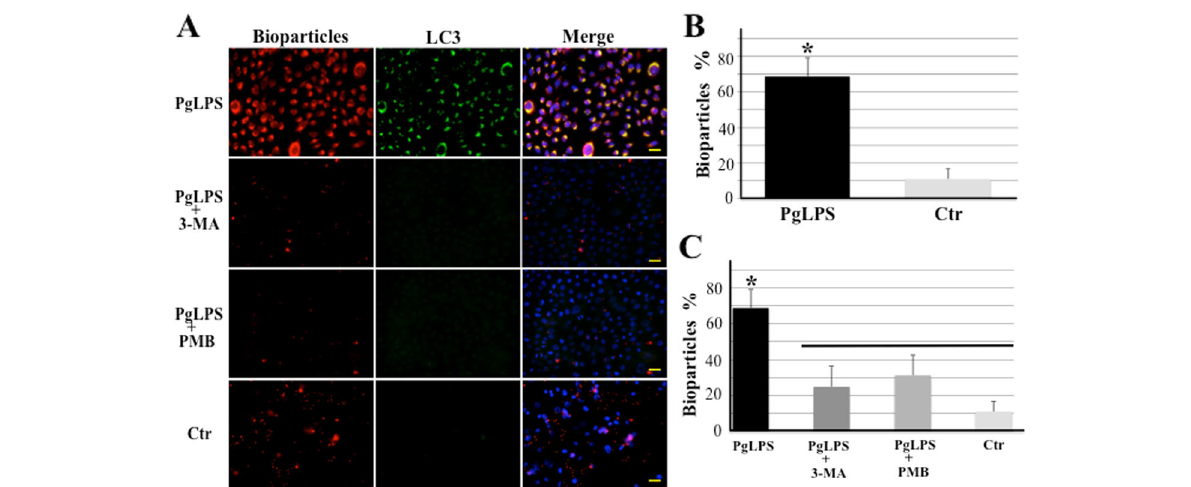
Fig. 8 Co-localization of E. coli BioParticles with autophagosomes is promoted by PgLPS-induced autophagy. HaCaT cells were infected with Alexa Fluor 568-labeled E. coli BioParticles for 1 h. Following phagocytosis, HaCaT cells were treated for 24 h under control condition (Ctr), pgLPS (10 μ g/ml), or pgLPS + 3-MA (10 mM), and pgLPS + PMB (100 μ g/ml). a Representative fluorescence images of co-localization between bioparticles (red) and LC3-II-positive autophagosomes (green). Nuclei were stained with Hoechst 33342 (blue). Bar = 25 μ m. b Quantification of the co-localization of bioparticles with LC3-II-positive autophagosomes in HaCaT cells treated with or without PgLPS. The graph shows the means ± SD from five independent studies. *Significantly different (Student ’ s t-test) at P < 0.05 compared with control (Ctr). c The graph shows quantification of co-localization of E.coli BioParticles with autophagosomes in HaCaT cells pretreated with or without inhibitors. All values are presented as the means ± SDs from five independent studies. *Significantly different at P < 0.05 compared with control (Ctr), PgLPS+ 3-MA, and PgLPS+PMB (ANOVA followed by Scheffe ’ s test). There are no significant differences between groups joined by horizontal